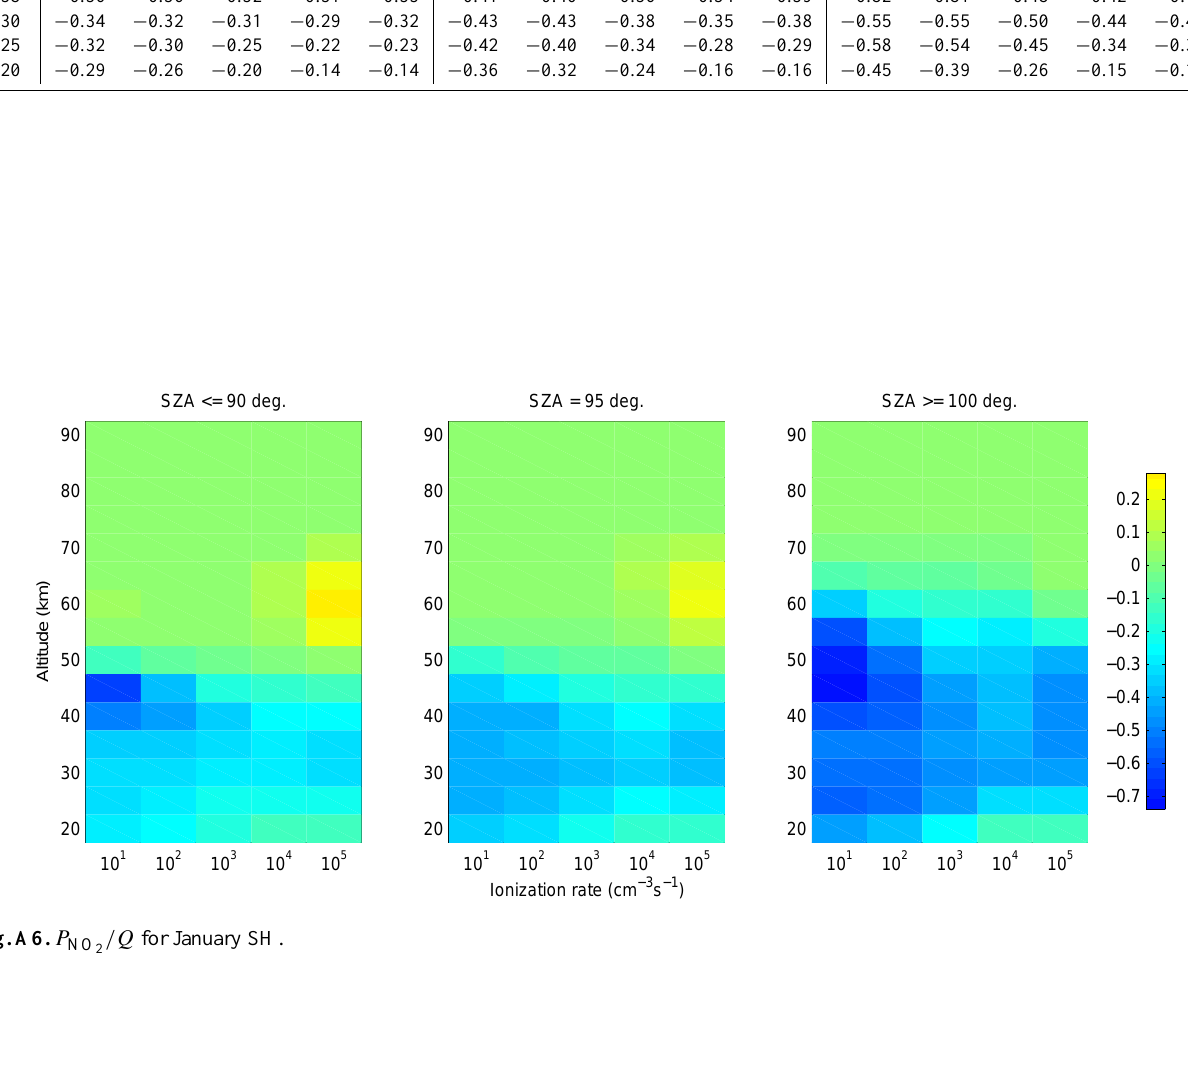
/Q for January 2